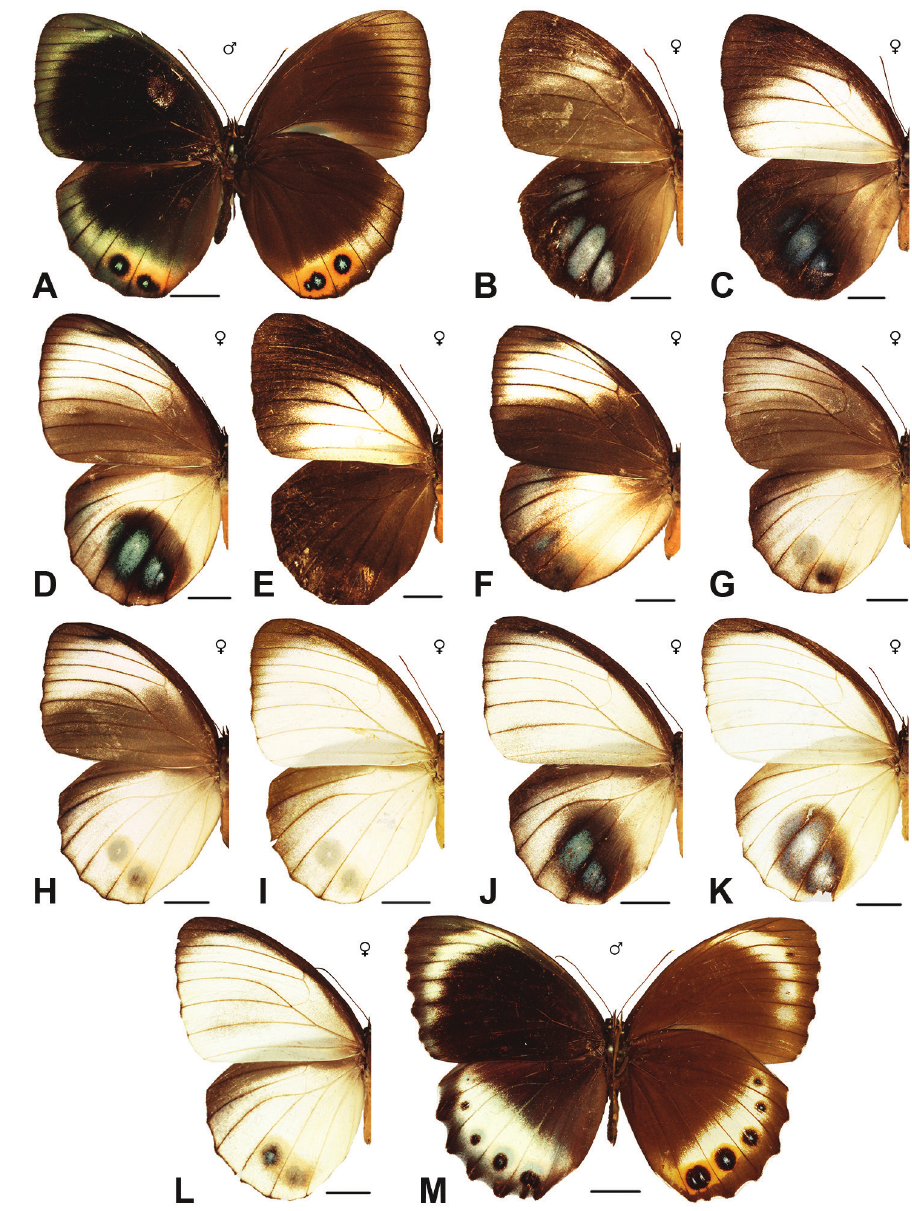
Figure 18. A agondas melagondas ♂ D+V NHM New Guinea B agondas melagondas ♀ D NHM New Guinea C agondas melagondas ♀ D NHM New Guinea D agondas melagondas ♀ D NHM New Guinea E agondas melagondas ♀ D NHM New Guinea F agondas melagondas ♀ D NHM New Guinea G agon- das melagondas ♀ D NHM New Guinea H agondas melagondas ♀ D NHM New Guinea I agondas mel- agondas ♀ D NHM New Guinea J agondas melagondas ♀ D NHM New Guinea K agondas melagondas ♀ D NHM New Guinea L agondas melagondas ♀ D NHM New Guinea M agondas goramensis ♂ D+V NHM Indonesia: Maluku, East Seram Regency, Gorong